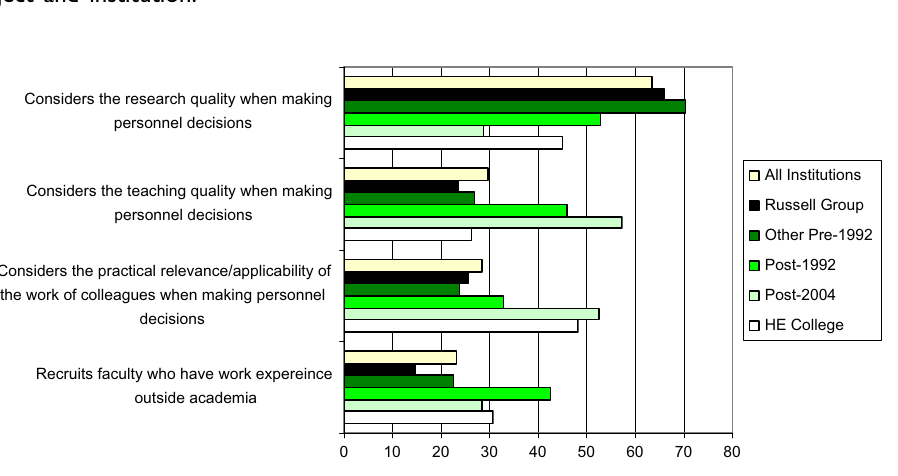
Figure 2. CAP Study: academic work – institutional emphasis in personnel decisions, by institution type